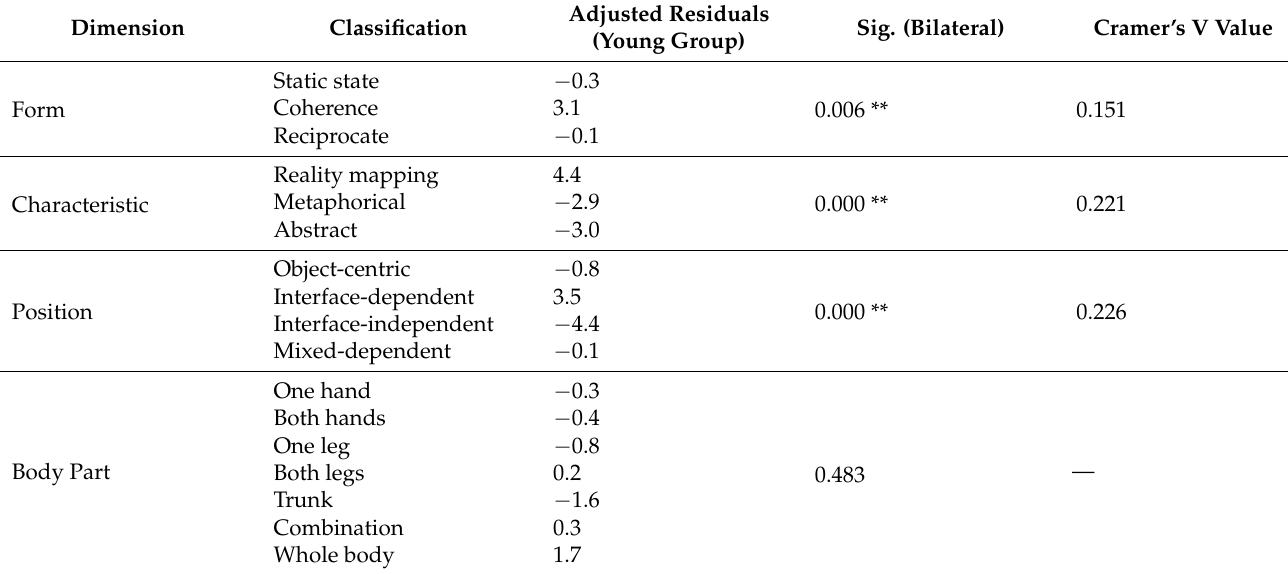
Table 4. Chi-square test results of two groups in different